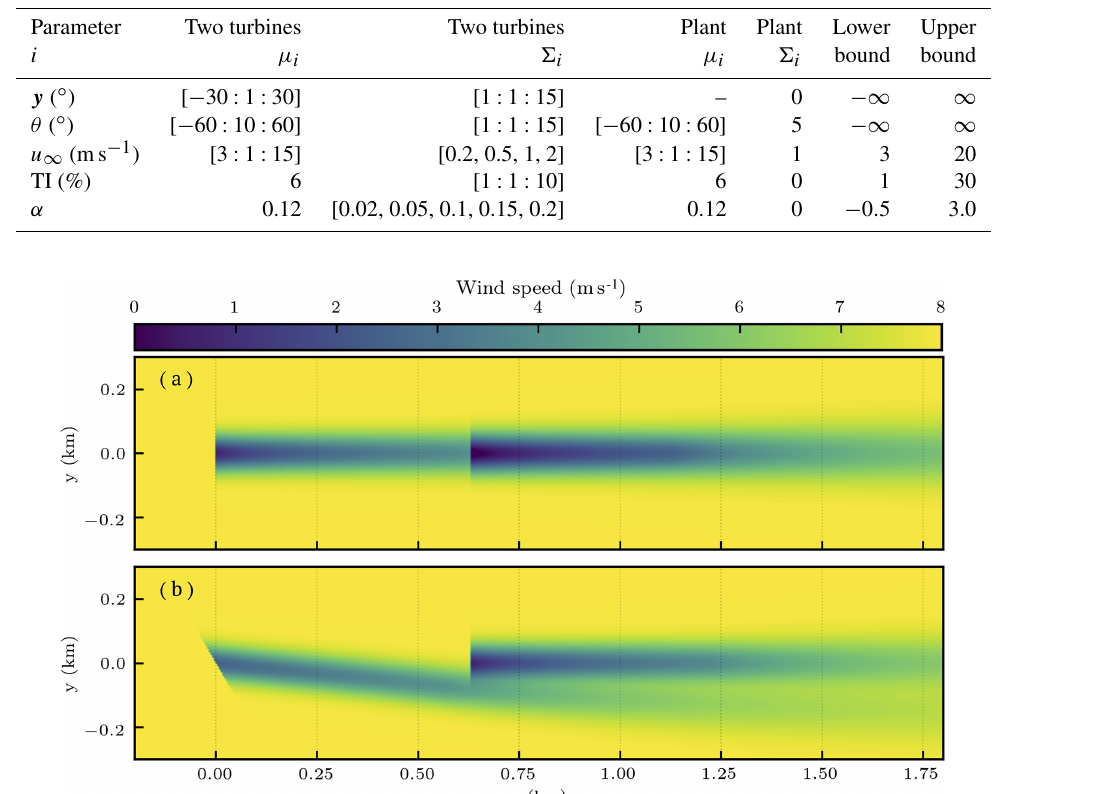
Figure 3. Contours of wind speed for a simple two-turbine test case with an inflow speed of 8ms − 1 . Brighter colors correspond to faster wind speeds. In (a) , the turbines are both directly facing the wind with y set to 0 . In (b) , the front turbine is offset such that y 1 = 30 ◦ and y 2 = 0 ◦ .